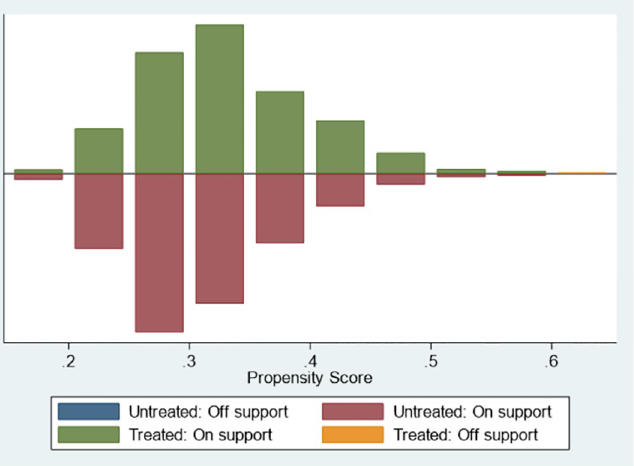
Fig 4. Matching result diagram. The regression results based on PSM samples are shown in Table 8. The coefficient of taxfirm � post is significantly negative in both Column(1) and Column(2), indicating that the conclusions of baseline still hold after controlling the difference of treated and controlled